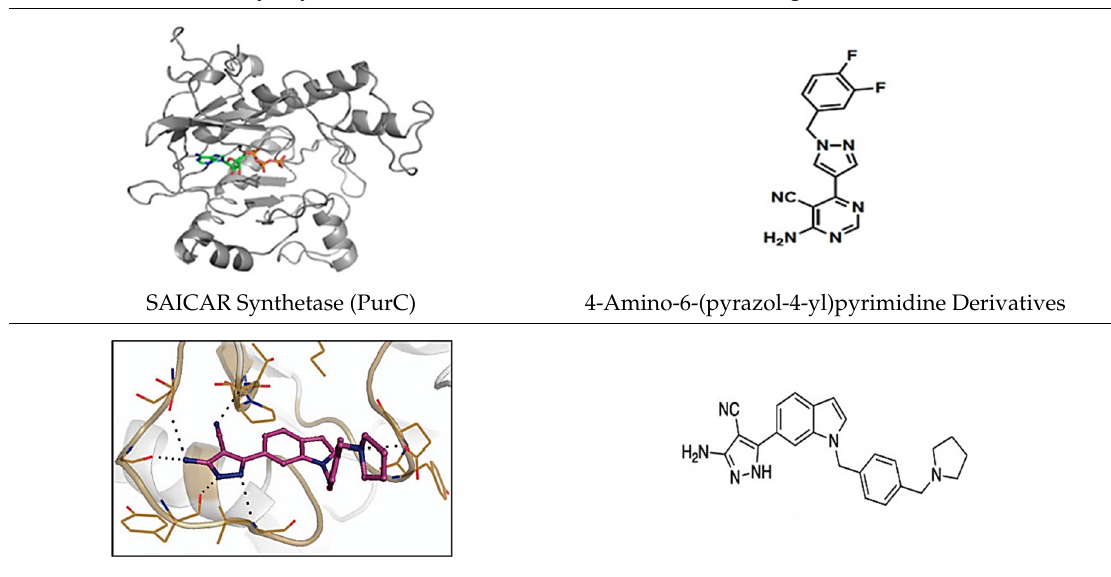
Table 2. X-ray crystal structures and respective fragment hit chemical structures.